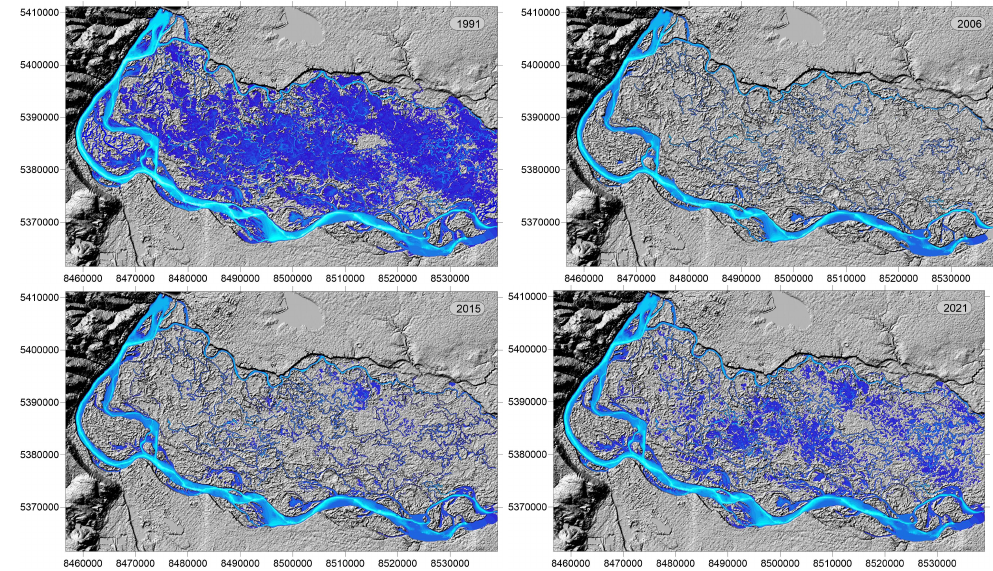
Figure 9. Examples of the VAF flooding dynamics calculations for hydrographs of different